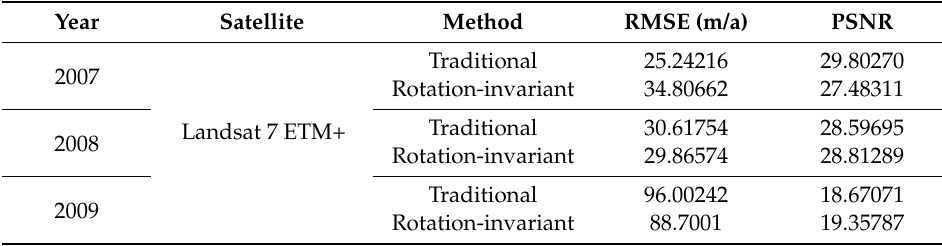
Table 3. The accuracies of the different methods compared with the MEaSUREs InSAR-based Antarctic ice velocity map (m/a) (Profile from C to D).